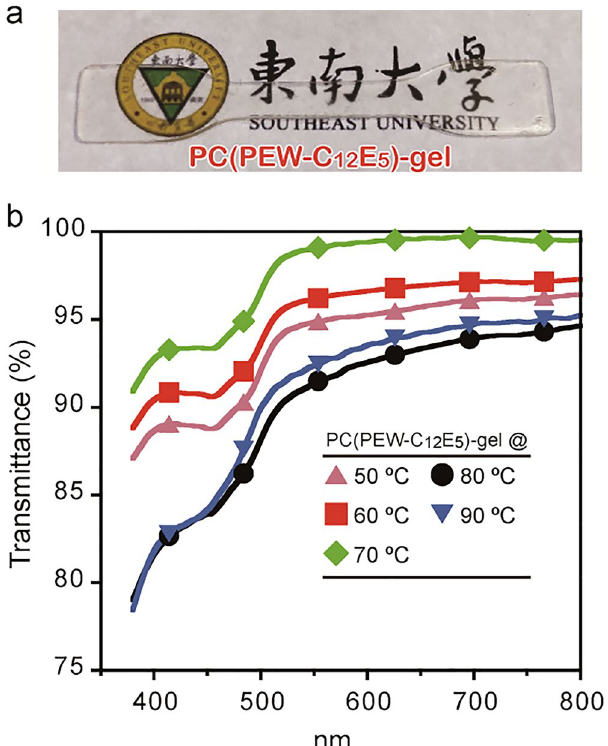
Figure 4. Pigeon egg white proteins based transparent gel ( a ) PC(PEW-C 12 E 5 )-gel was prepared by heating